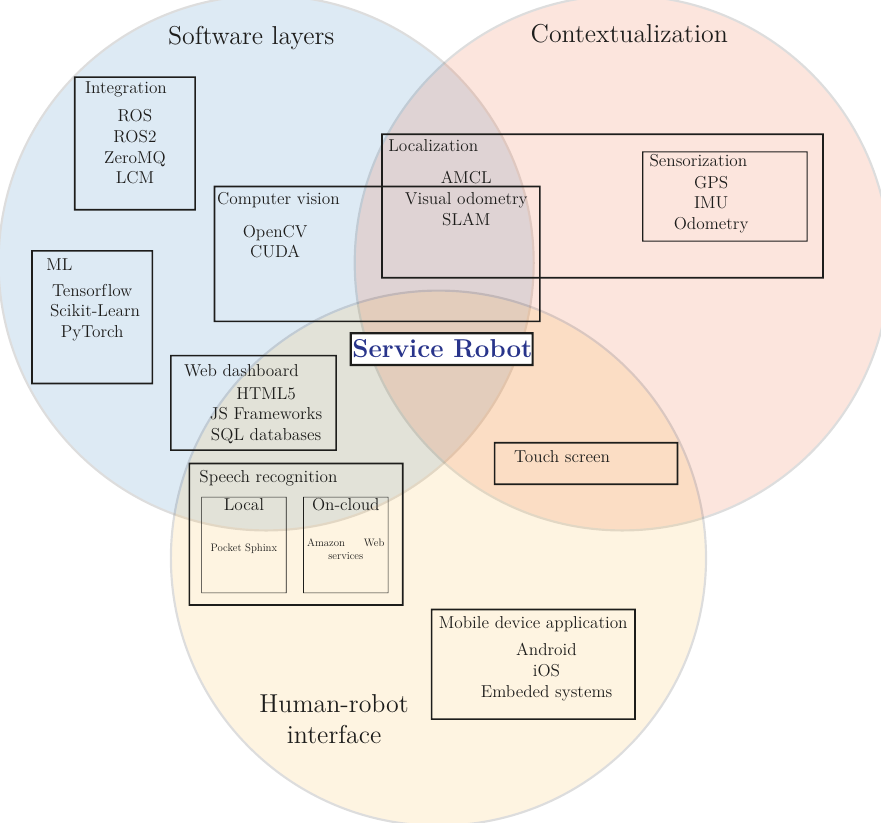
Figure 4. Common components of a service robot with examples of the technological stack available as in